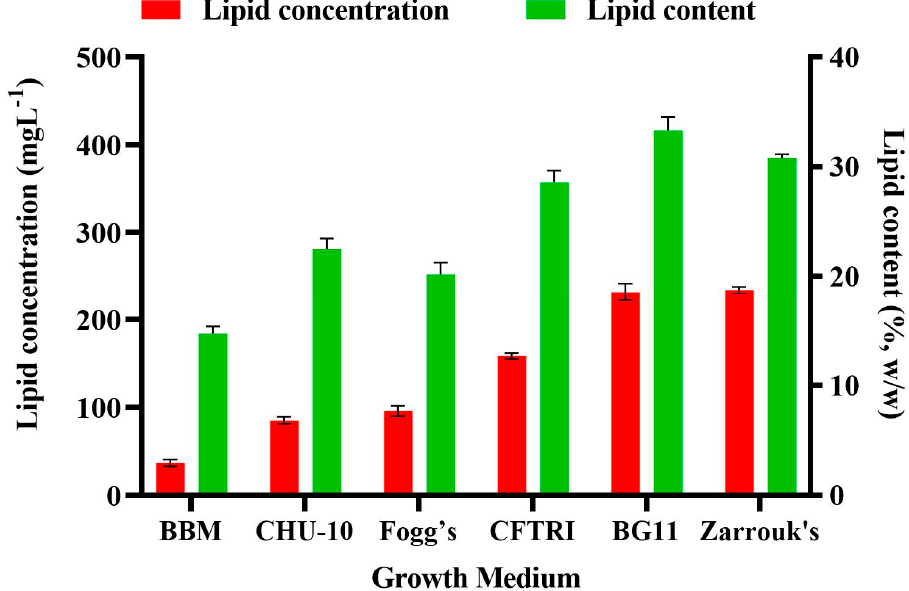
Figure 5. Estimation of lipid concentrations and lipid content of S. rotundus MG910488 after cultiva- tion in various medium.